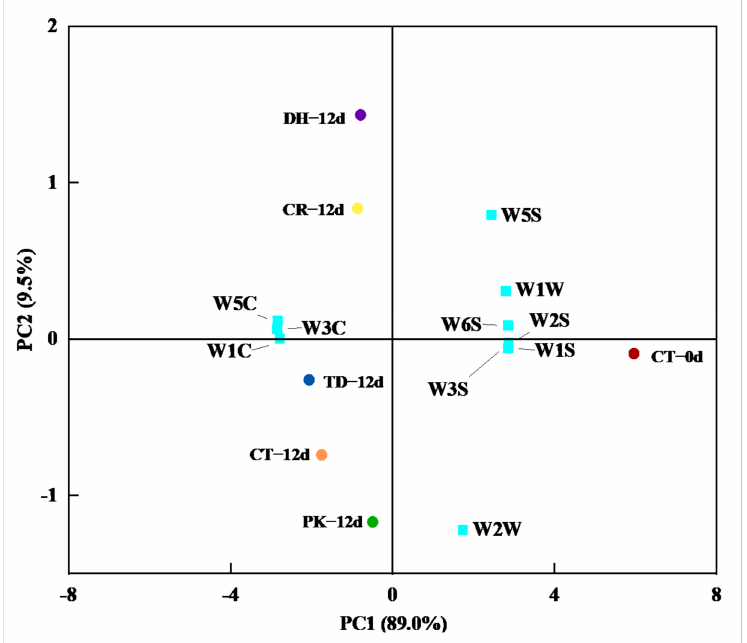
Figure 1. Principal component analysis of electronic nose data for the control and reduced-salt dry sausages with and without yeast inoculation on days 0 and 12. CT: 2.50% NaCl; CR: 1.75% NaCl; PK: